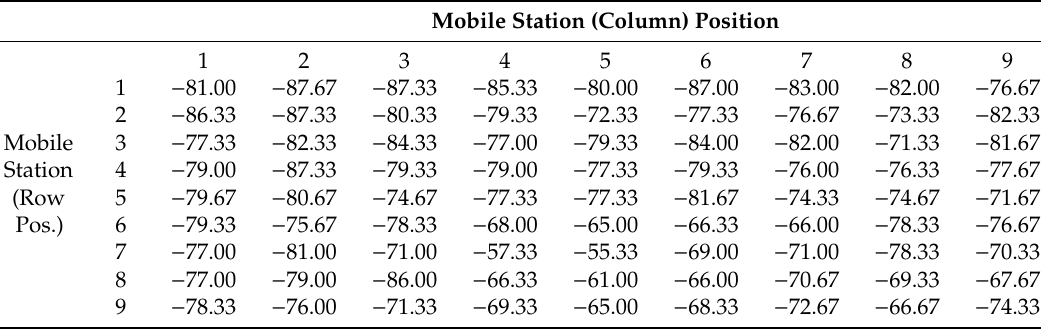
Table 1. Measured RSSI for MeS 1 (position 75: row 7, column 5).